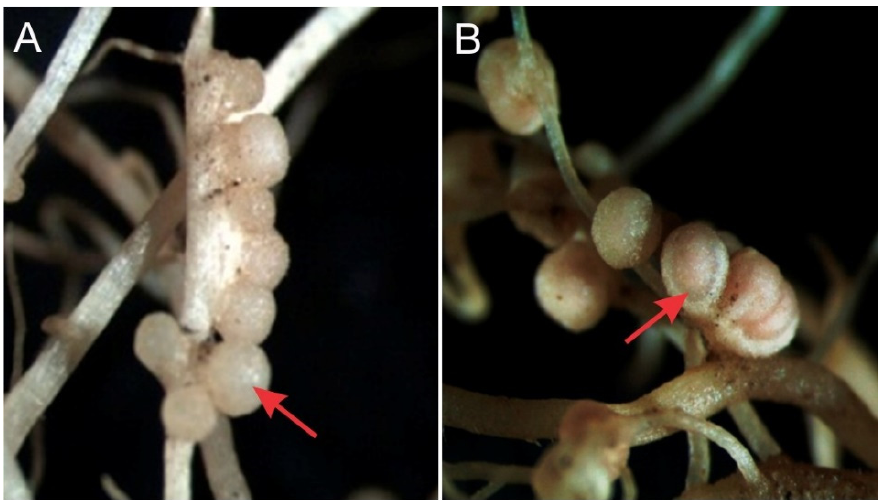
Figure 1. Red arrows point ( A ) Non-functional nodules generated in soil B3. ( B ) Functional nodules in soil B1 (40× magnification).